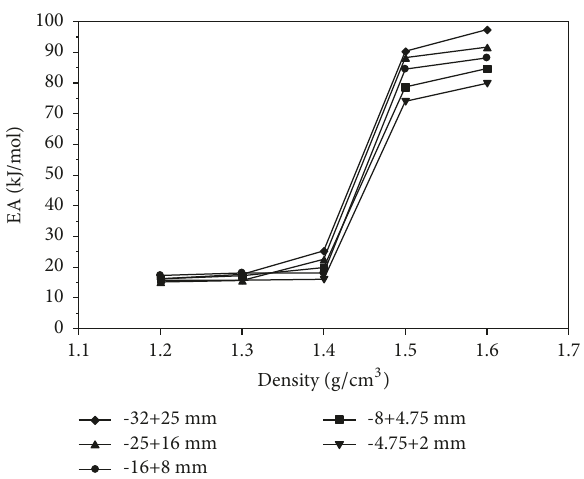
Figure 8: Activation energies of floated coal samples at different densities after the float and sink